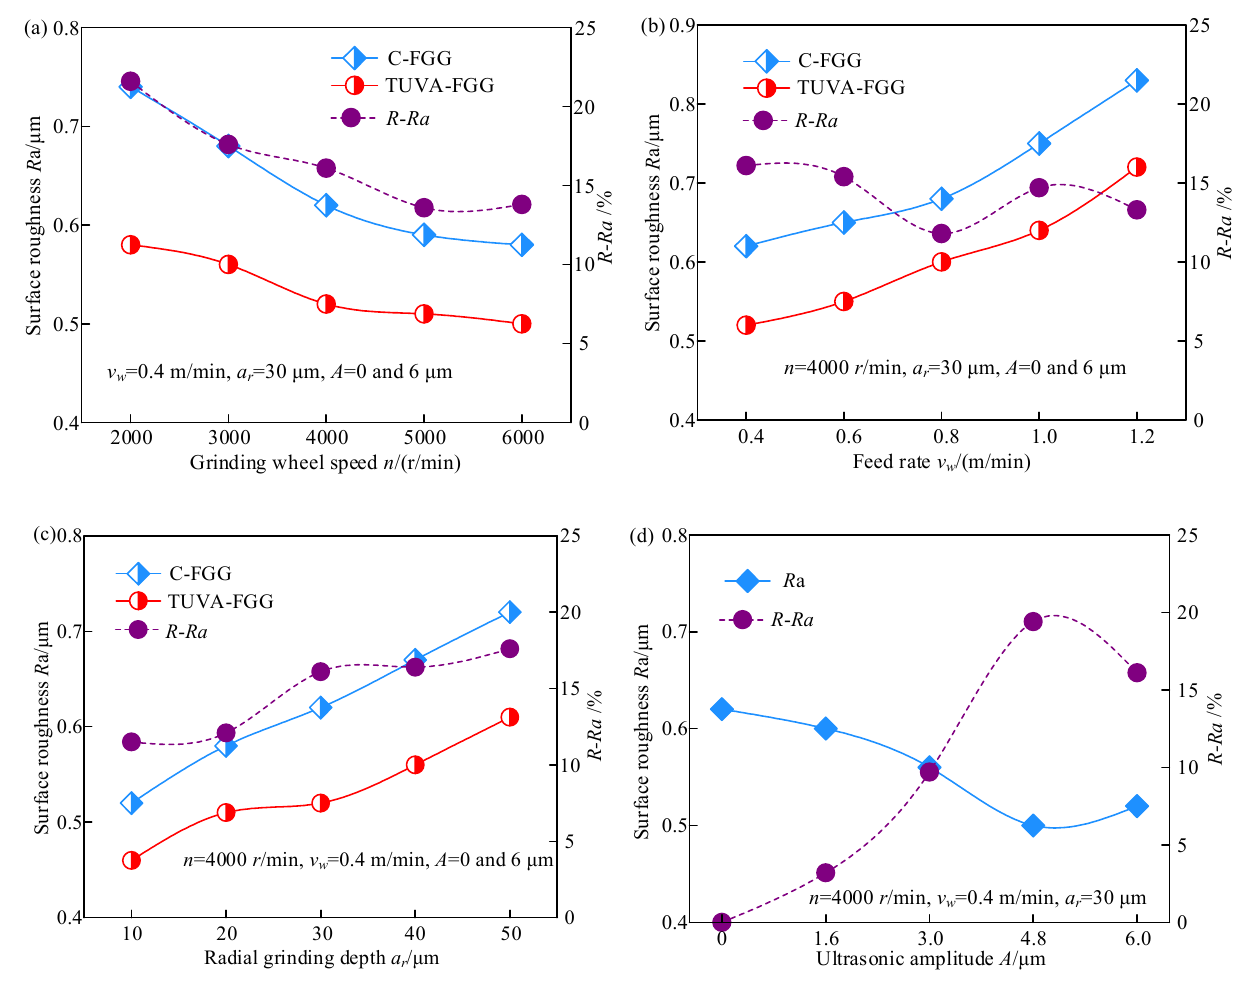
Figure 5. Effects of processing and ultrasonic parameters on the surface roughness: ( a ) grinding wheel speed, ( b ) feed rate, ( c ) radial grinding depth, and ( d ) ultrasonic amplitude.